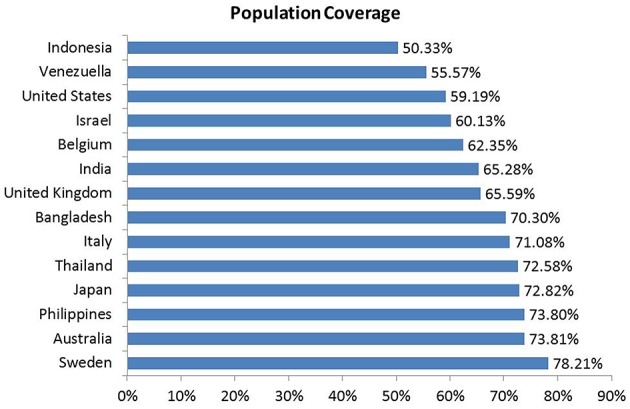
Population coverage of different strains of VP4 protein. The peptides with different HLA binding specificities will increase the population coverage as the various HLA types are expressed at radically different frequencies in various ethnicities. The populations were grouped upon 14 countries for our study.